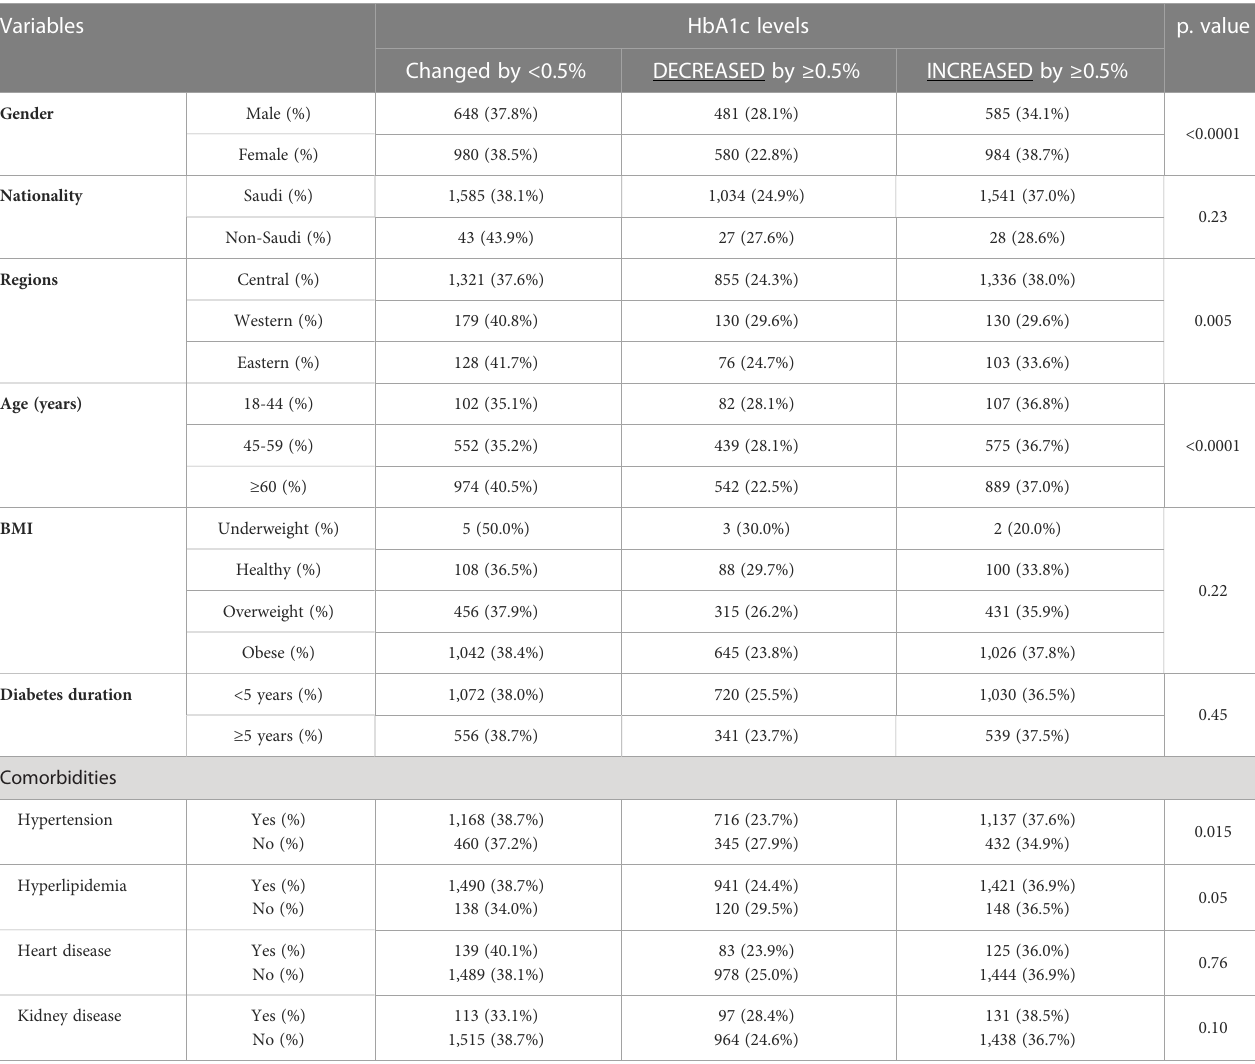
TABLE 3 Association of different demographic variables with HbA1c changes by more or less than 0.5% throughout the lockdown period in T2DM patients.